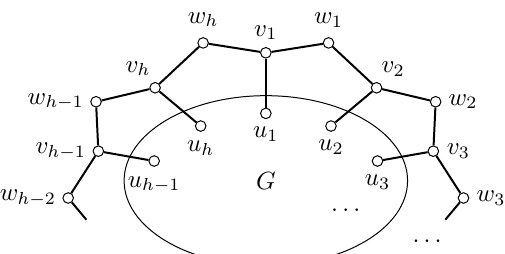
Figure 1: The altan a ( G, H ) . Attachment of the annulene to the graph G is via the set H = { u alternate vertices of the annulene { v